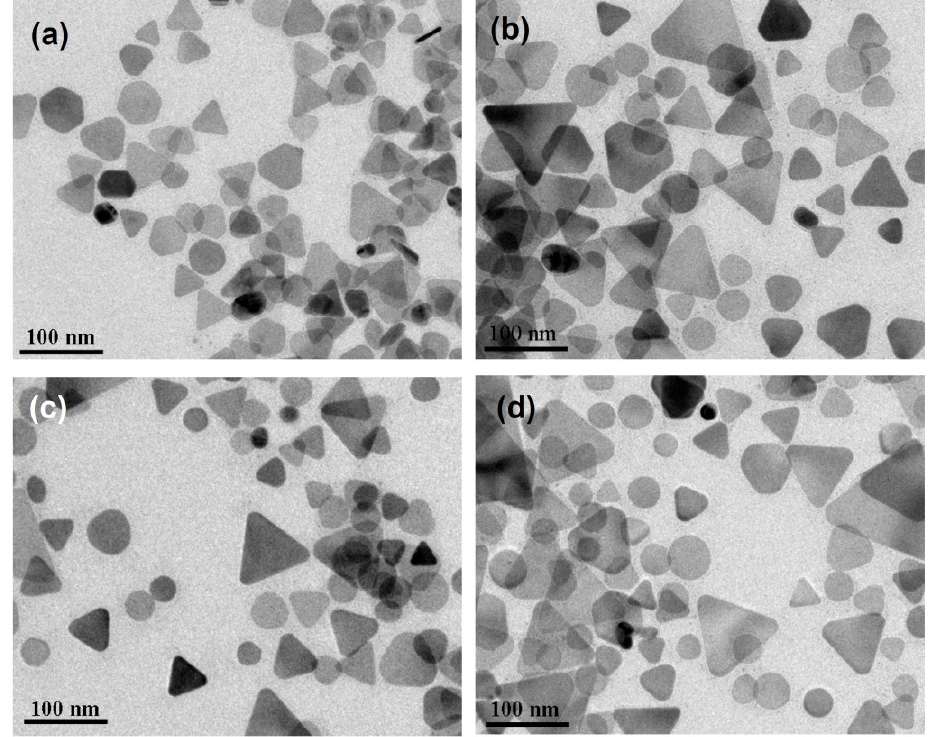
Figure 6. TEM images of the silver nanoparticles synthesized at 60 °C and at different reaction times: ( a ) 35 min; ( b ) 80 min; ( c ) 210 min and ( d ) 300 min.